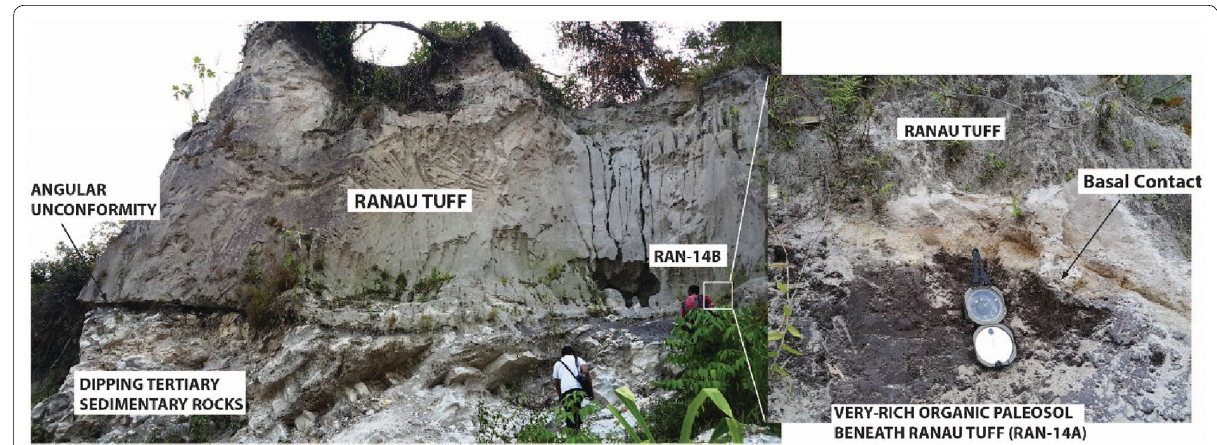
Fig. 7 Exposures of the distal Ranau Tuff near Muaradua (Lat,Lon: were collected. The tuff is separated from tilted sedimentary rocks by a thick, organic-rich paleosol